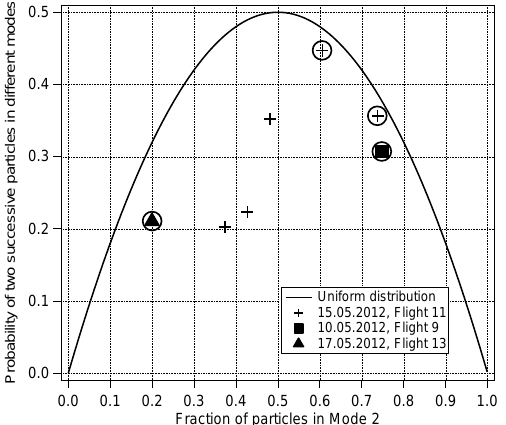
Figure 9. Statistical “proximity” analysis for the measured bimodal droplet size distributions. The black line shows a theoretical, uni- form distribution between both modes. The results from Fig. 8a (i.e., abscissa = 0.606 = 60.6% and ordinate = 0.447 = 44.7%) indicate that the measured bimodal size distribution is close to uniform dis- tribution. Four of the seven bimodal size distributions (marked by circles) show a good agreement with the theoretical, uniform distri- bution.